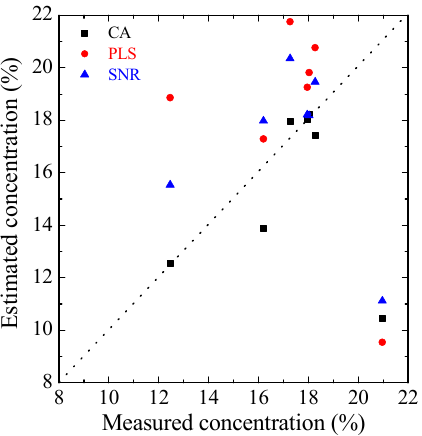
Figure 12. Estimated oxygen concentrations with CA, PLS, and